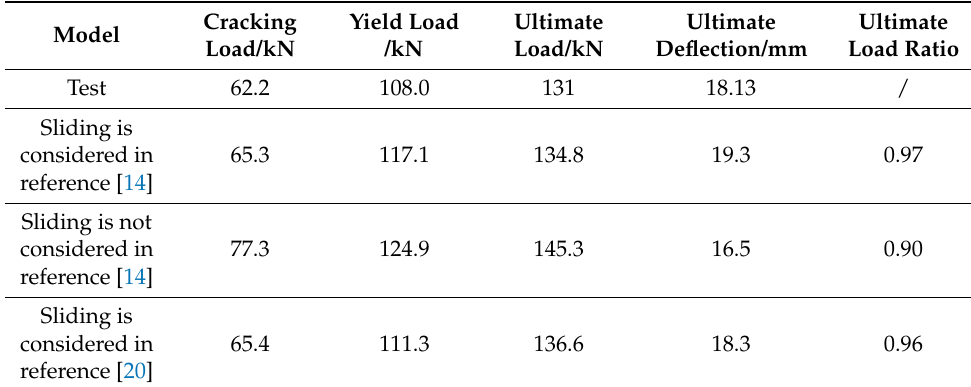
Figure 9. Load-deflection curve of numerical simulation and test results. Table 3. Comparison of finite element simulation results and test results.